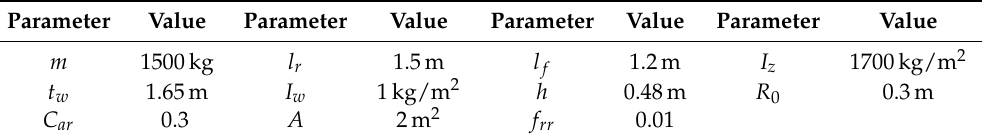
Table 1. Vehicle